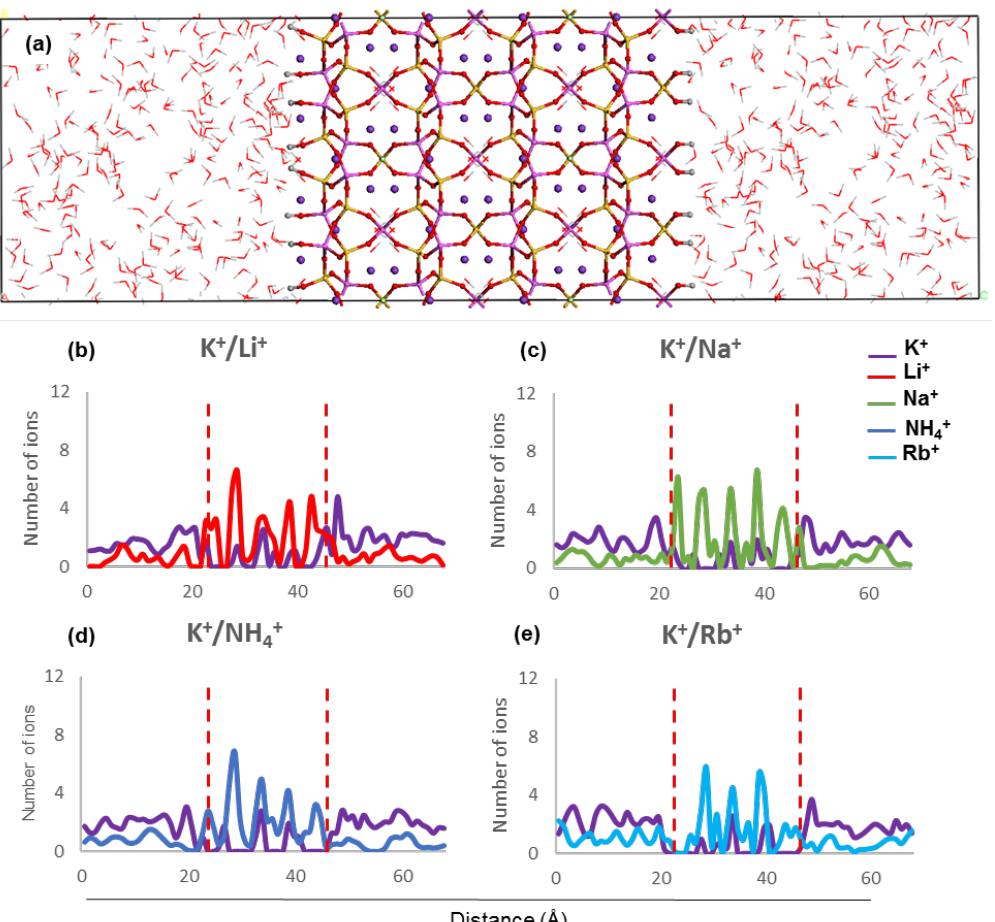
Figure 2. ( a ) ZM-001 simulation box along the z direction and ( b – e ) ion concentration profiles along the z direction after 8.5 ns MD simulations. The two red dashed lines indicate the location of ZM-001 surfaces in the electrolyte solution.